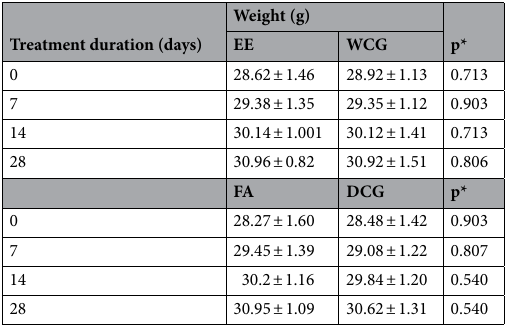
Table 5. Weight of mice treated with repeated doses of ethanolic extract or alkaloid fraction from Aspidosperma nitidum. EE ethanolic extract, FA fraction of alkaloids, WCG water control group, DCG DMSO control group (99% water + 1% DMSO). * p value was obtained by Student’s T-test, comparing EE versus WCG, or FA versus DCG.